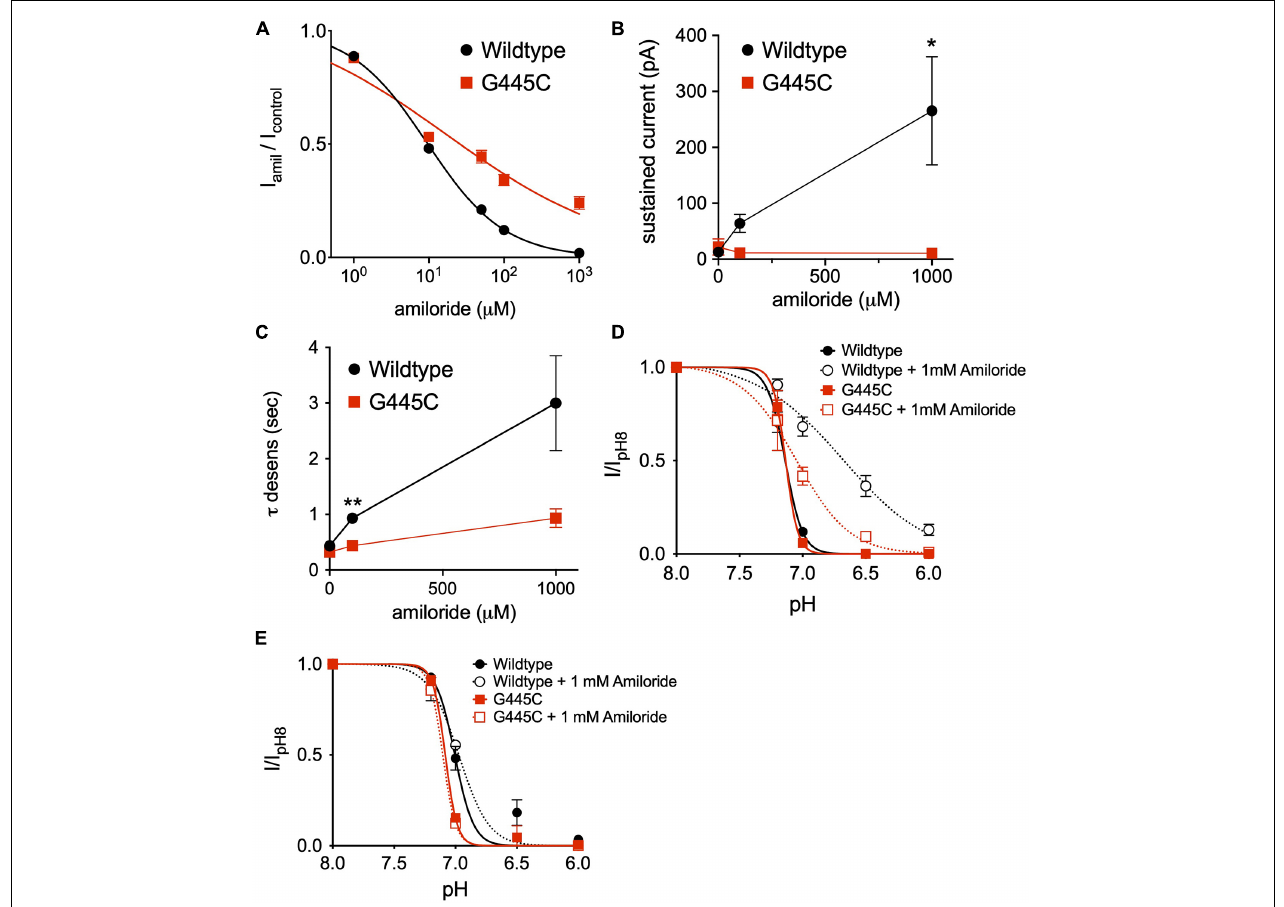
FIGURE 9 | An amiloride binding site within the pore of ASIC3 contributes to paradoxical block and potentiation. (A) Dose-response curves for amiloride inhibition of pH 6-evoked currents on ASIC3 wildtype and G445C mutant channels. Lines are fits of Hill equation (IC 50 = 9.47 µ M (wildtype, n = 10) and 17.3 µ M (G445C, n = 9; p < 0.001 two-way ANOVA) (B) Mean pH 6.8-evoked sustained current amplitudes measured from ASIC3 wildtype ( n = 14) or G445C mutant channels ( n = 5) in 0, 0.1, 1 mM amiloride ( p = 0.13 two-way ANOVA with multiple comparisons: * p = 0.03 wildtype vs. G445C at 1 mM amiloride). (C) Mean time constants of desensitization ( τ ) of pH 6.8-evoked currents measured from ASIC3 wildtype ( n = 18) or G445C mutant channels ( n = 14) in 0, 100, 1,000 µ M amiloride ( p < 0.001 two-way ANOVA with Bonferroni post hoc showing ** p < 0.001 for wildtype vs. G445C at 100 (D) pH dose-response curves for steady-state desensitization (SSD) in ASIC3 wildtype ( n = 10) or G445C mutant channels ( n = 5–12) recorded at -70 mV holding potential. Lines are fits of the Hill equation [pH 50 = 7.13 (wildtype), 6.70 (wildtype + 1 mM Amiloride), 7.13 (G445C), 7.05 (G445C + 1 mM Amiloride)] (E) pH dose-response curves for SSD in ASIC3 wildtype ( n = 10) or G445C mutant channels ( n = 2) recorded at + 50 mV holding potential. Lines are fits of the Hill equation [pH 50 = 7.08 (wildtype), 7.00 (wildtype + 1 mM Amiloride), 7.10 (G445C), 6.97 (G445C + 1 mM